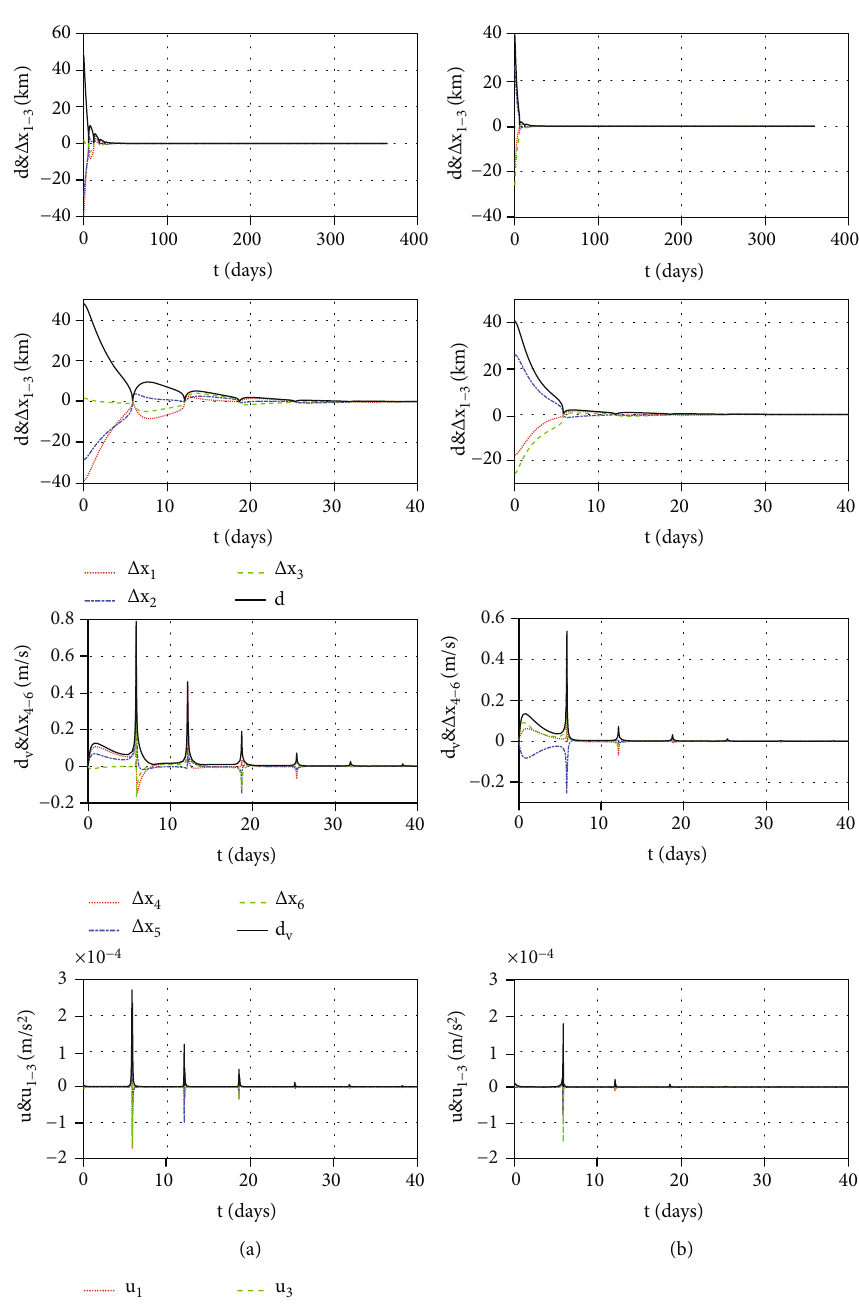
Figure 6: The position deviations, velocity deviations, control inputs and the zoomed fi gures when the LQR (a) and OSMC controllers (b) are applied to the 9:2